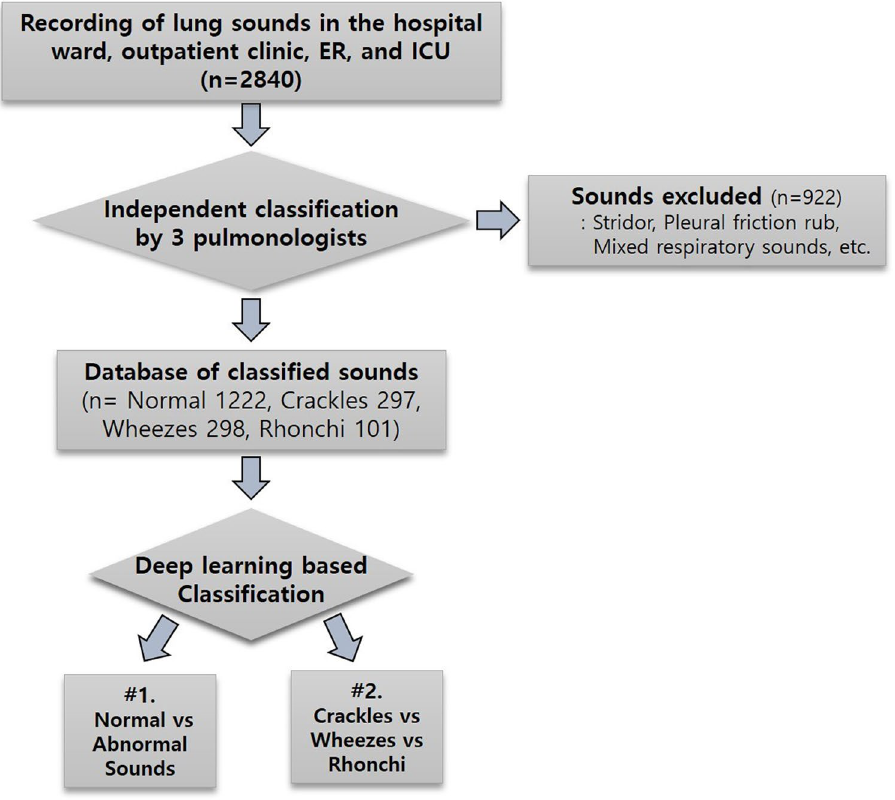
Figure 1. Scheme of the classification of respiratory sounds using deep learning. Lung sounds database contains normal sounds, crackles, wheezes, and rhonchi. Deep learning was used for two types of classification: The first step is the discriminating normal sounds from abnormal sounds. The second is to categorize abnormal sounds into crackles, wheezes, and rhonchi. (ER: Emergency room, ICU: intensive care unit).